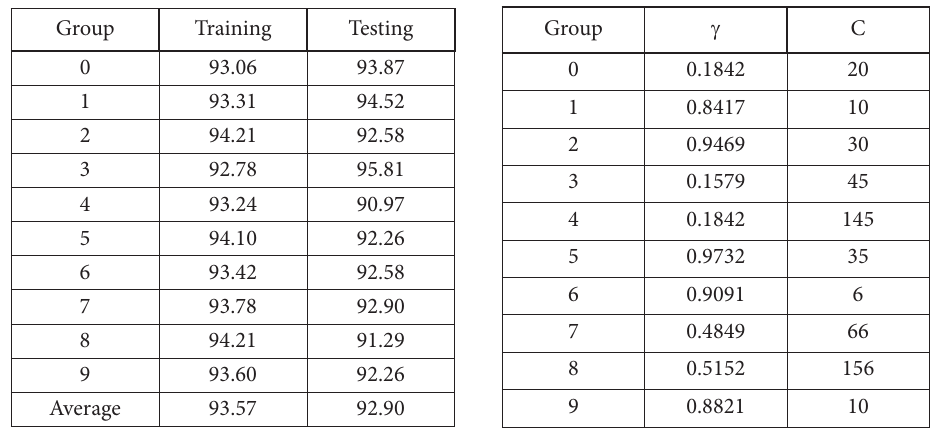
Table 4. Accuracy rates ( R A ) for testing and train- ing cases (%) Table 5. Kernel ( g ) and penalty (C) parameters